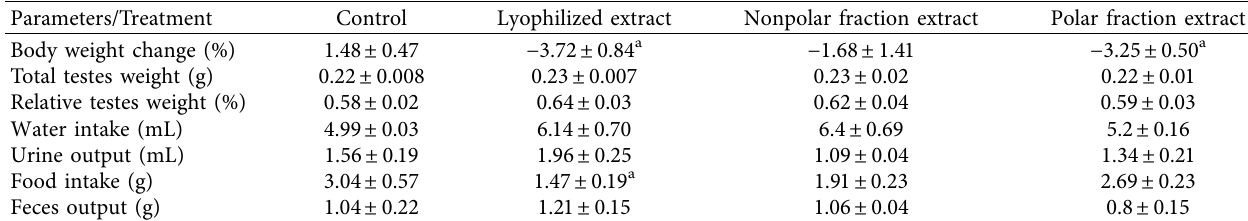
Table 2: Effects of three different date pit extracts on some physiological parameters in mice.